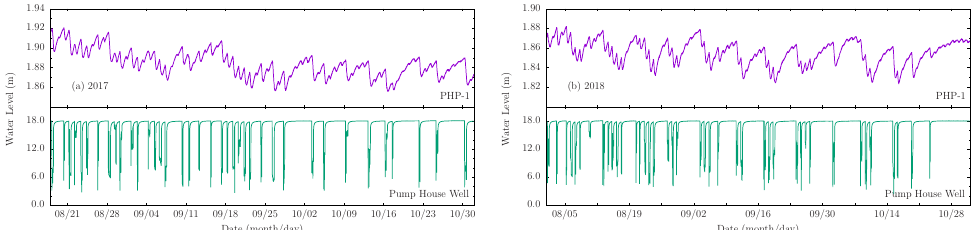
Figure 12. Groundwater fluctuations observed in piezometer PHP-1 and the Pump House irrigation well ( a ) from 18 August 2017 to 1 November 2017, and ( b ) from 1 August 2018 to 1 November